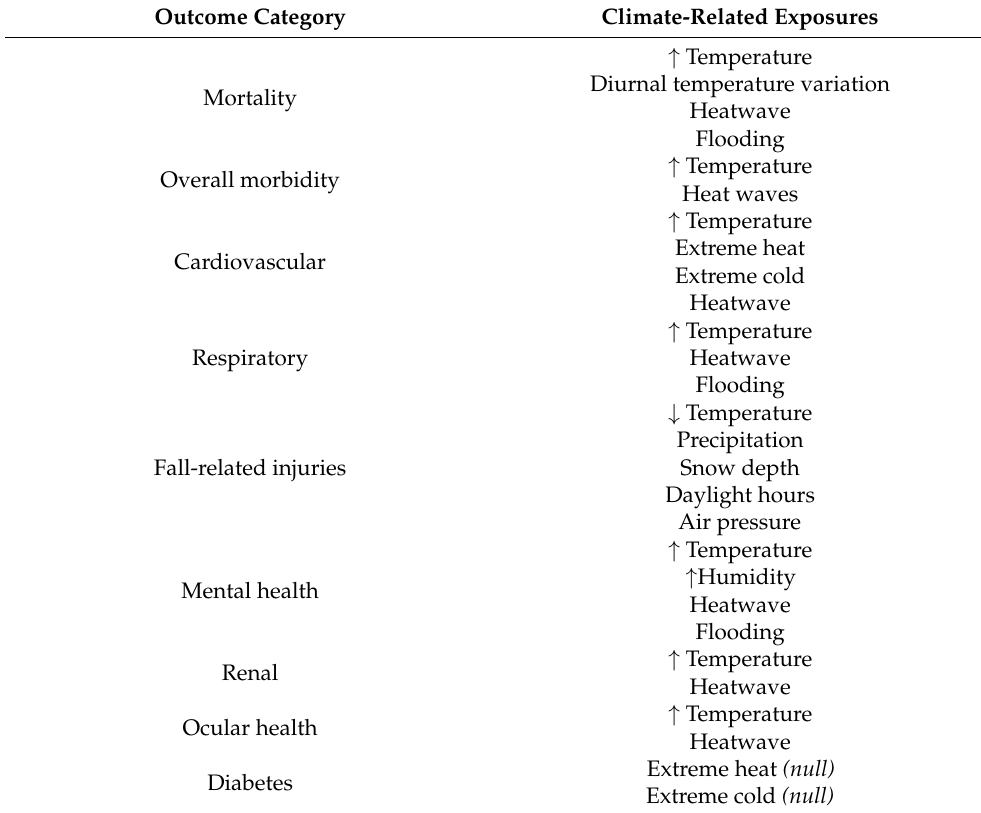
Table 2. Summary of outcomes and associated meteorological parameters in older adults. An increase or decrease in the value of a parameter is denoted by ↑ or ↓ ,